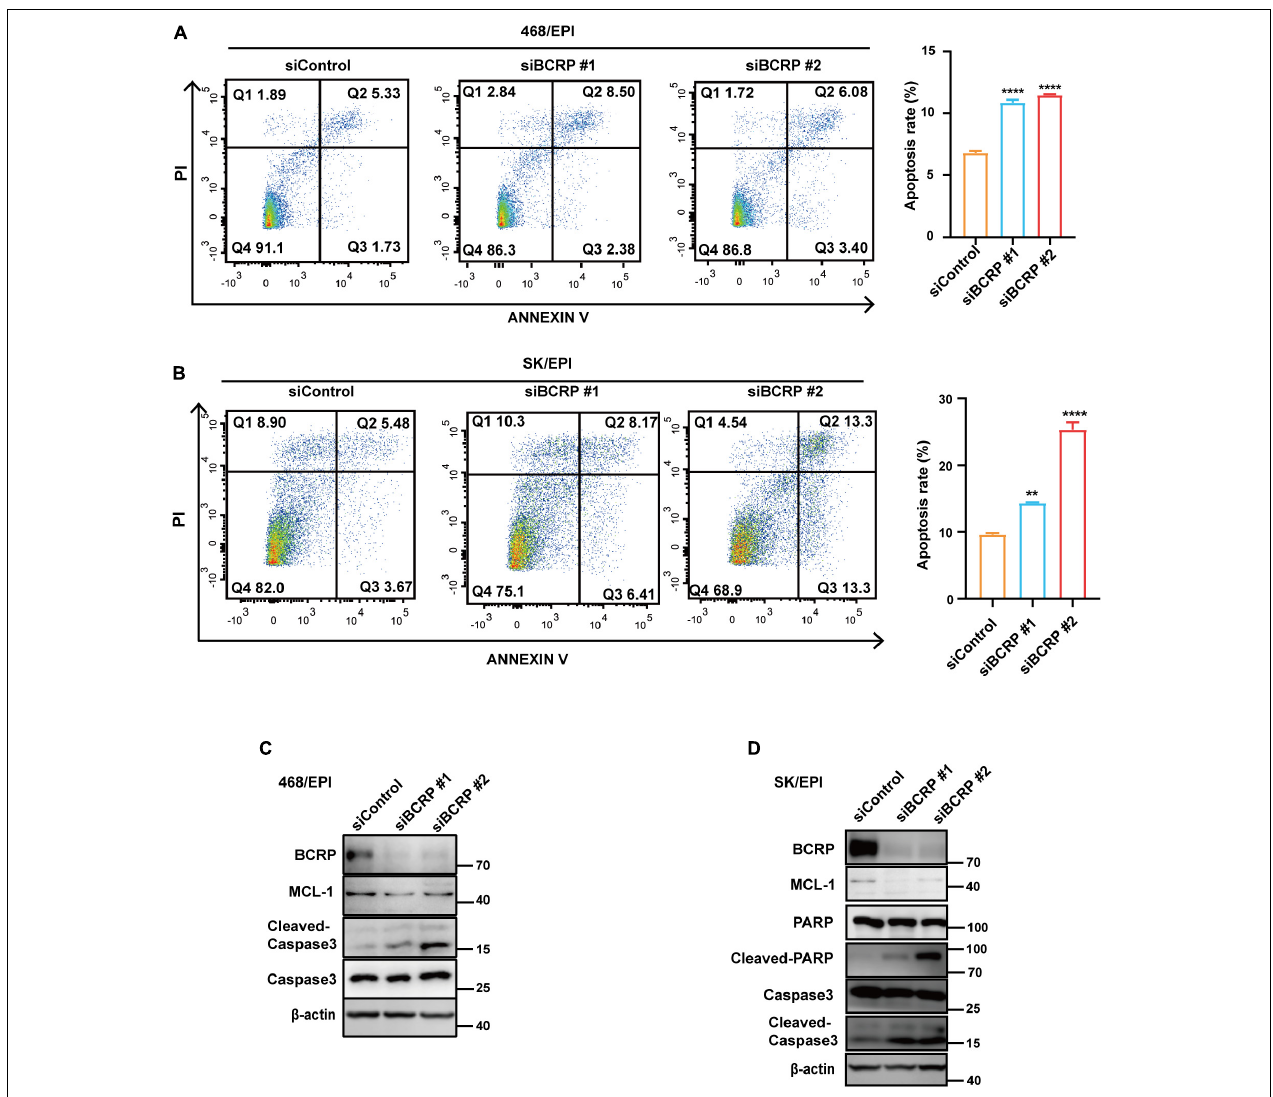
FIGURE 3 | Loss of BCRP promotes the apoptosis of drug-resistant breast cancer cells. (A,B) Apoptosis rate of 468/EPI cells (A) and SK/EPI cells (B) with or without BCRP silencing, as measured by flow cytometry. The cells were treated with siBCRP siRNAs for 72 h and then subjected to apoptosis analysis. (C,D) Western blot analysis of apoptosis-related proteins in 468/EPI cells (A) and SK/EPI cells with or without BCRP silencing. The cells were treated with siBCRP siRNAs for 72 h, and then, the proteins were analyzed by Western blot. All data are shown as the mean ± SD; independent Student’s t -test, ** p < 0.01, and **** p < 0.0001 versus control, N =